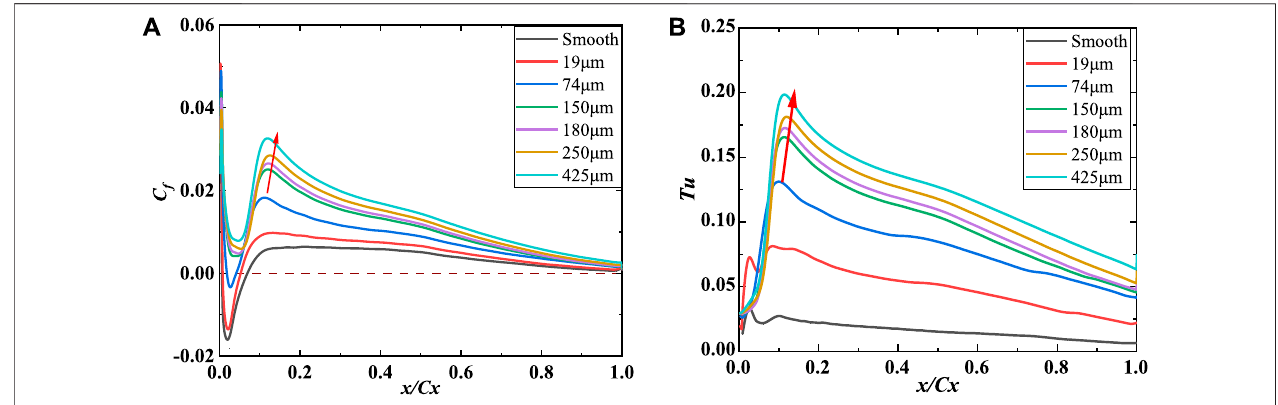
FIGURE 7 | Axial friction coef fi cient and turbulence level distribution of different roughnesses: (A) coef fi cient of axial friction resistance and (B) turbulence intensity.